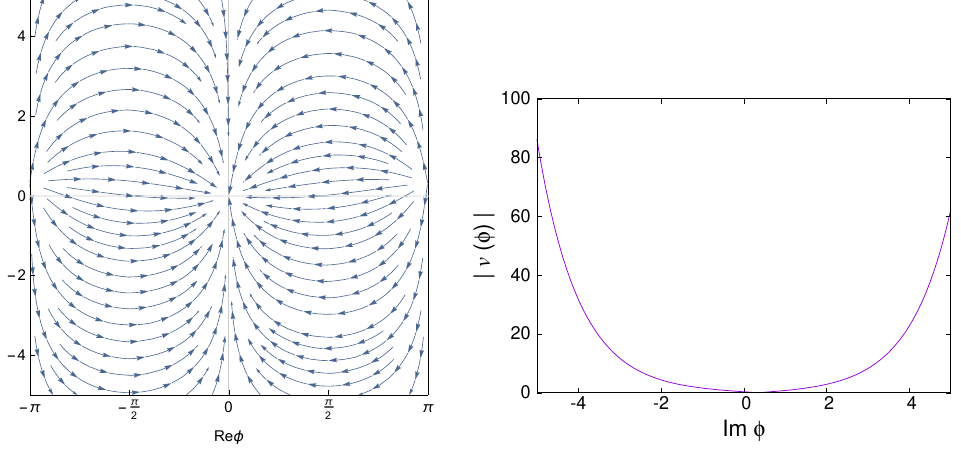
Figure 4 . (Left) A (cid:13)ow diagram representing (cid:12) = (cid:18) = 1. (Right) The absolute value